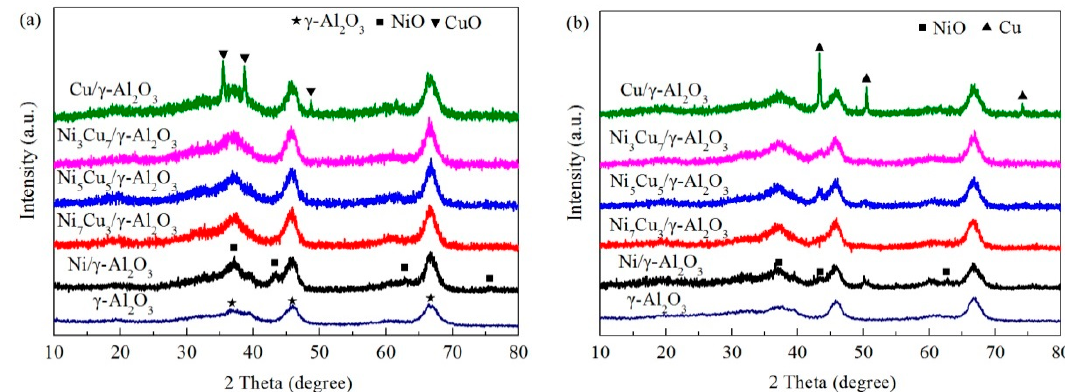
Figure 1. X-ray diffractometry (XRD) patterns of ( a ) fresh and ( b ) spent Ni x Cu (10- x ) / γ -Al 2 O 3 catalysts.